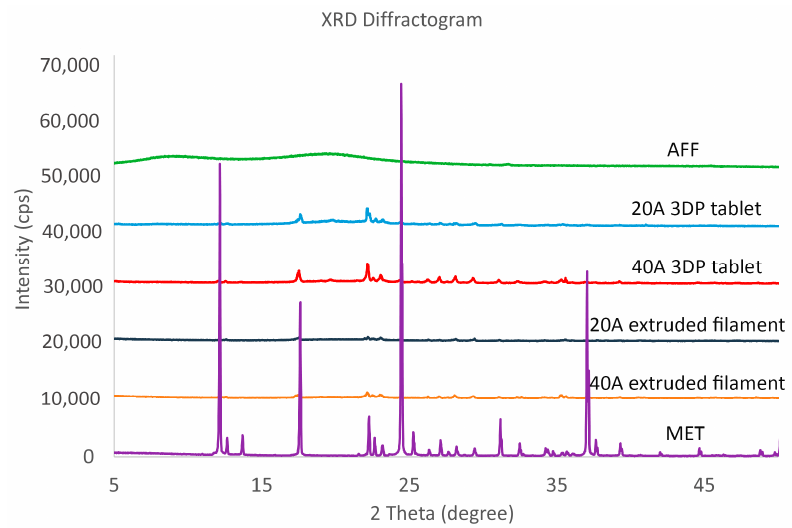
Figure 4. XRPD patterns of MET, AFF, 20A, and 40A extruded filaments, and 20A and 40A 3DP tablets.